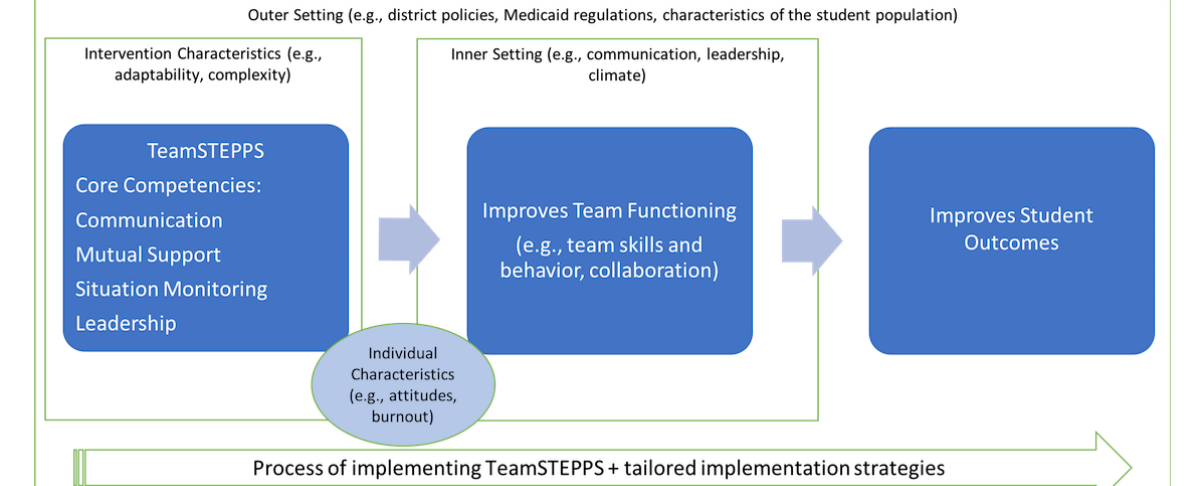
Figure 1. Guiding conceptual model. TeamSTEPPS: Team Strategies and Tools to Enhance Performance and Patient